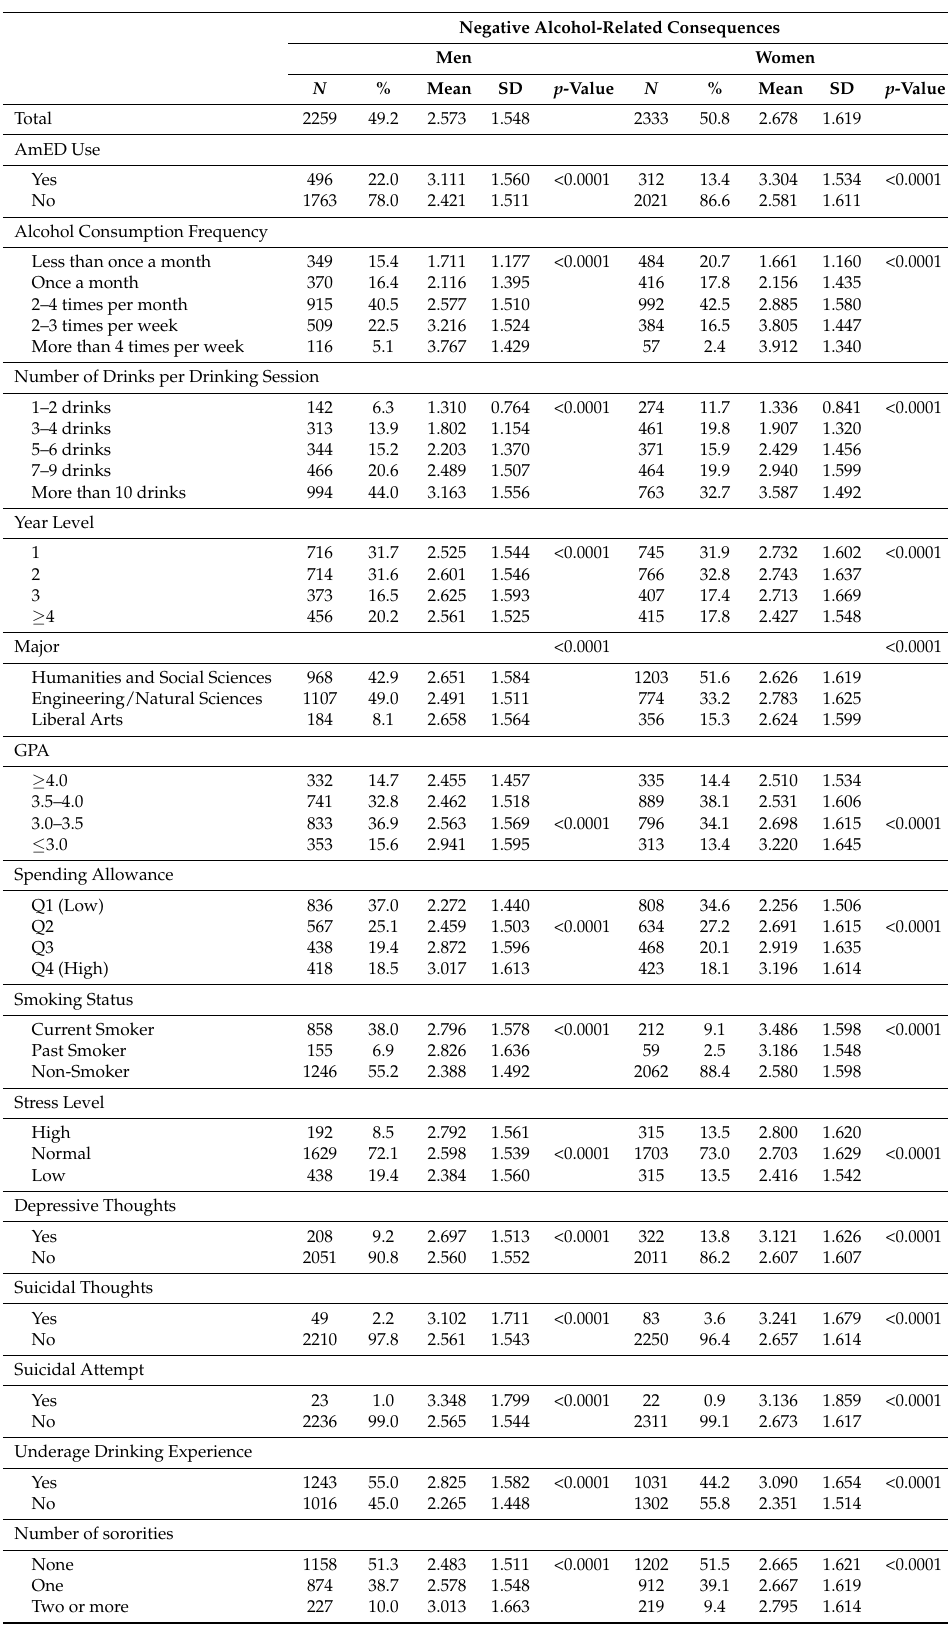
Table 1. Sociodemographic characteristics of study participants and negative alcohol- related